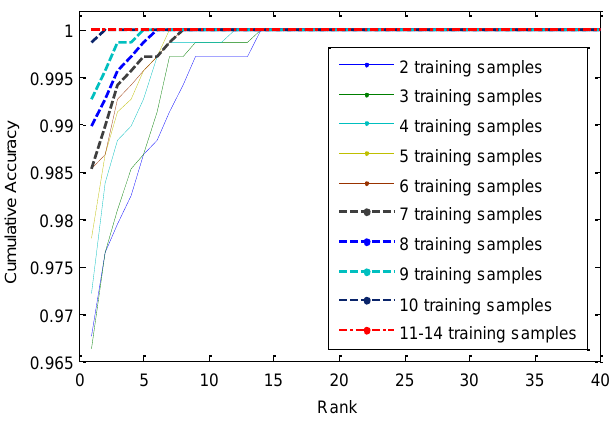
Figure 12. Cumulative match curves by different number of training samples.